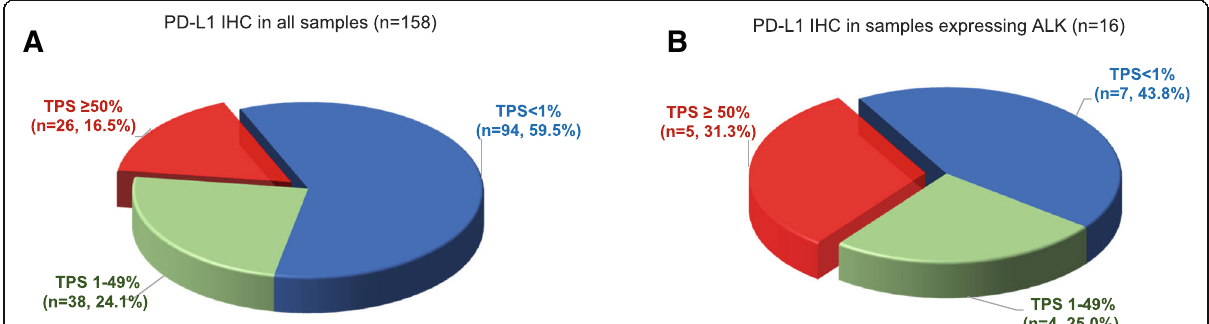
Fig. 2 PD-L1 TPS determined by IHC for lung adenocarcinoma patients ( a ) PD-L1 TPS for all 158 samples ( b ) PD-L1 TPS for the 16 samples expressing ALK. ALK: anaplastic lymphoma kinase, PD-L1: programmed cell death-ligand 1, TPS: tumor proportion score